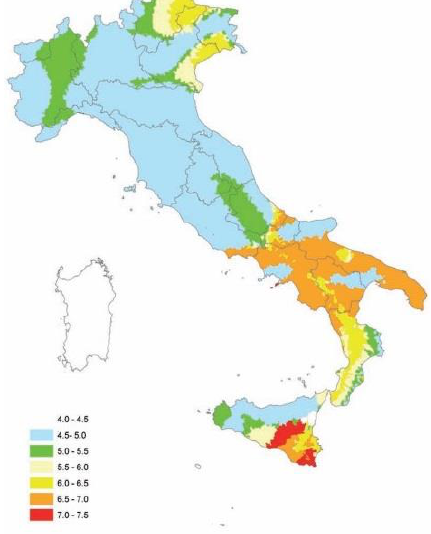
Figure 3. Modal values of M W from disaggregation [52].